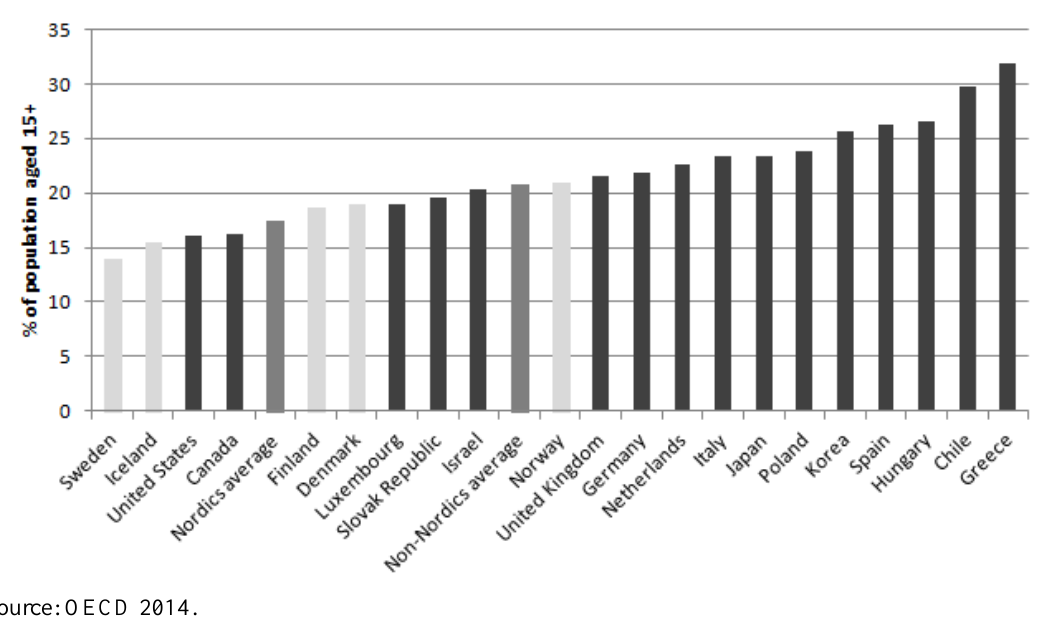
Figure 4: Percentage of population (aged 15+) who are daily smokers,